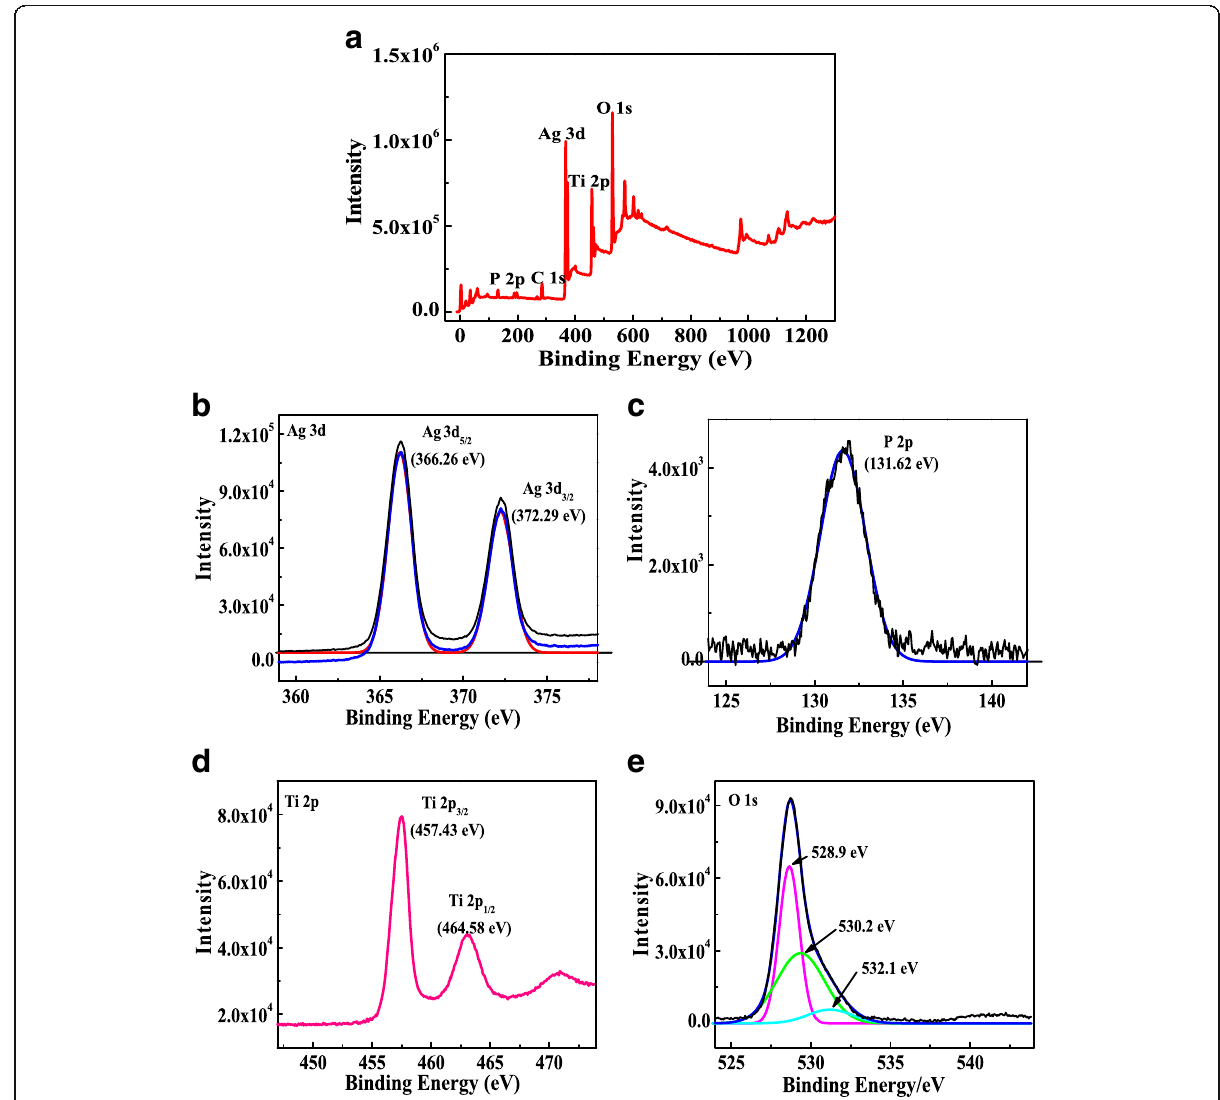
Fig. 3 XPS spectrum of TiO 2 400/Ag 3 PO 4 : a survery scan, b Ag 3d, c P 2p, d Ti 2p, and e